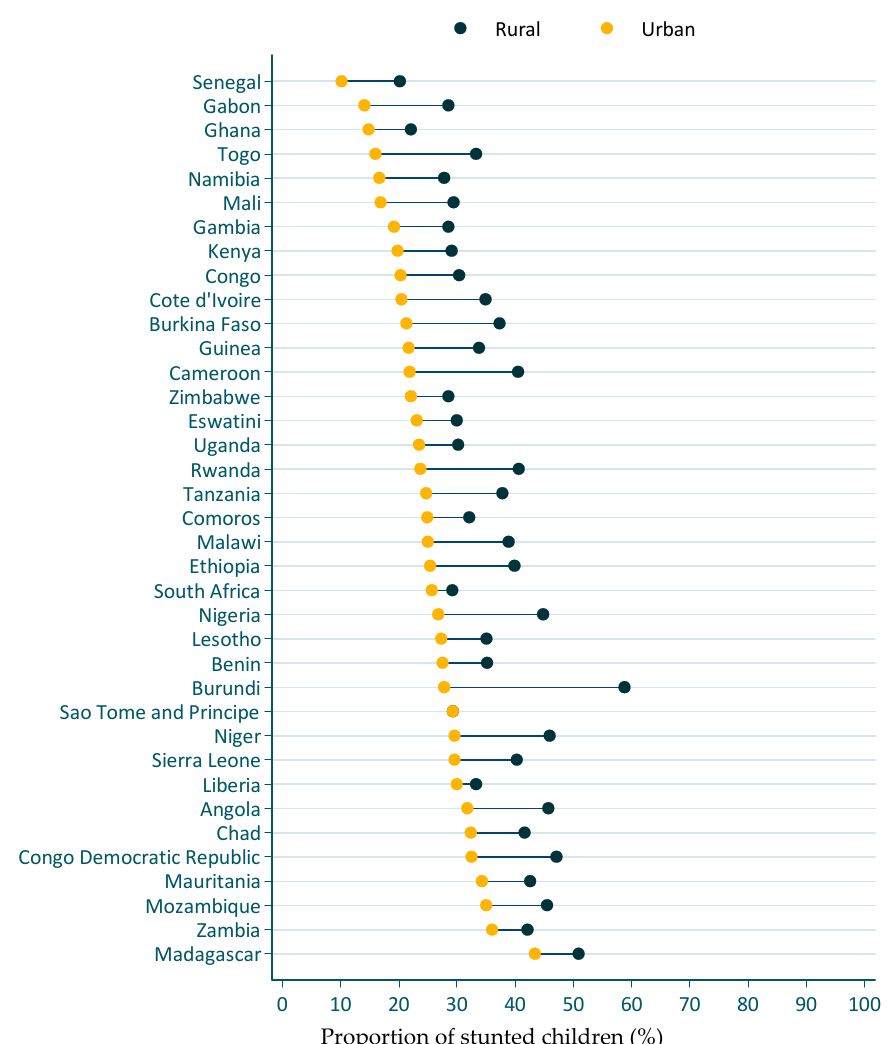
Figure 4. Stunting prevalence by rural / urban residence. Data is from the most recent demographic and health surveys. Dots show stunting prevalence estimates for children younger than five years of age residing in rural (navy blue) and urban (orange) residence.